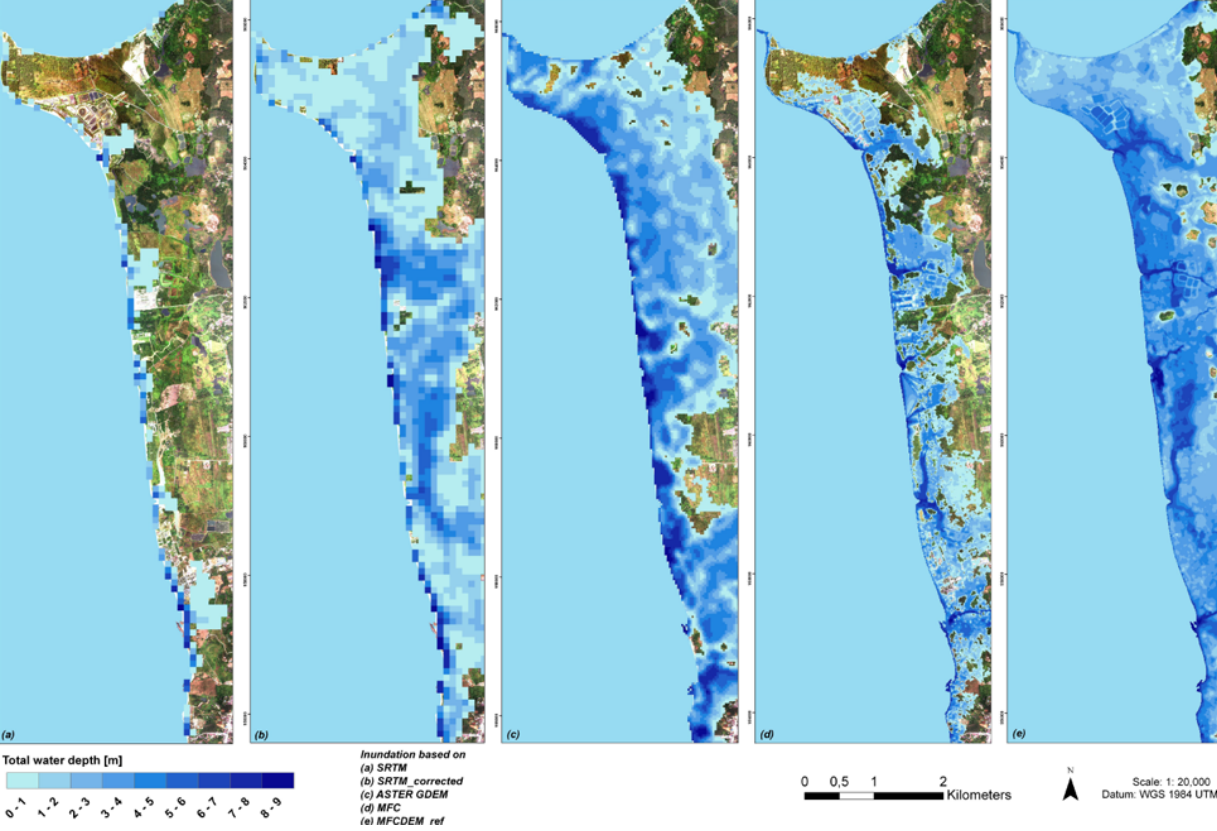
www.nat-hazards-earth-syst-sci.net/12/2103/2012/ Nat. Hazards Earth Syst. Sci., 12, 2103–2126,